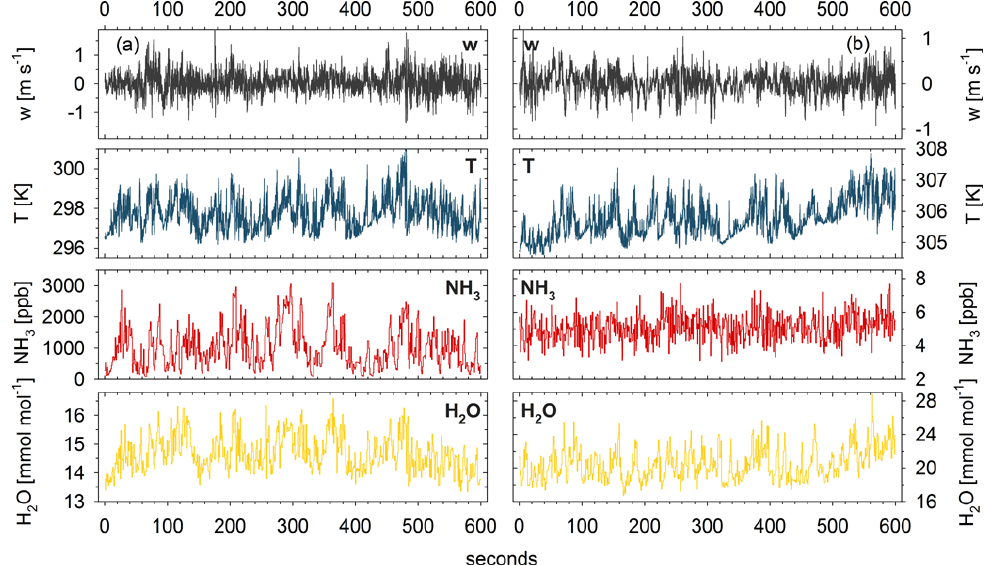
Fig. 5. Exemplary 20Hz time series of w , T , NH 3 and H 2 O obtained from sonic anemometer and HT-CIMS measurements on (a) 4